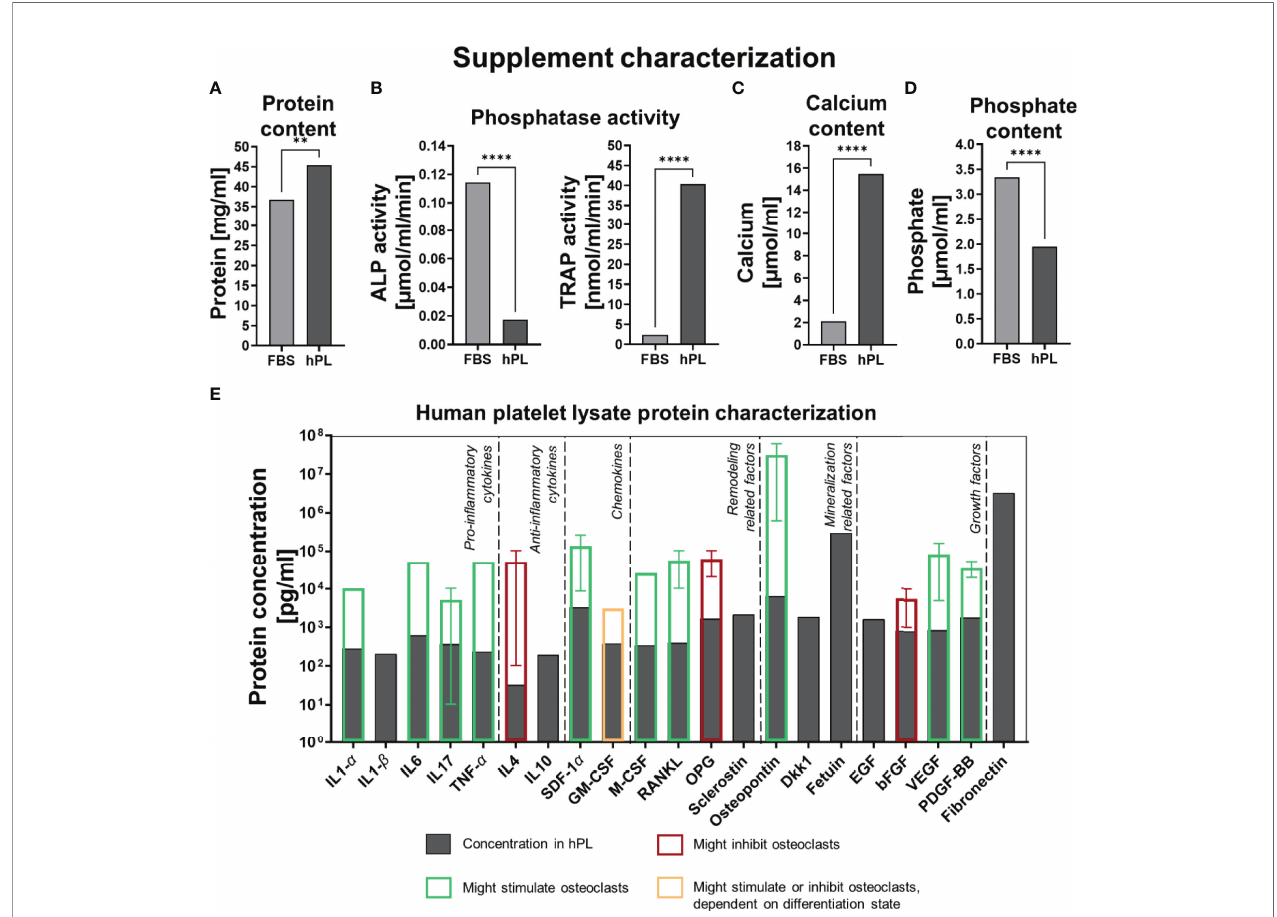
FIGURE 5 | (A) Protein concentration in FBS and hPL, p <0.05 (independent t-test). (B) Phosphatase activity (ALP and TRAP) in FBS and hPL, p < 0.05 (independent t-test). (C) Calcium concentration in FBS and hPL, p < 0.05 (independent t-test). (D) Phosphate concentration in FBS and hPL, p < 0.05 (independent t-test). Asterisks indicate signi fi cant differences (** p < 0.01, **** p < 0.0001). (E) Quanti fi cation of bone and bone-remodeling related factors in hPL. Transparent bars indicate the mean effective concentration found by in vitro experiments from literature, error bars represent minimal and maximal reported effective concentration, border color represents the direction of the found effect. fetal bovine serum (FBS), human platelet lysate (hPL), alkaline phosphate (ALP), tartrate resistant acid phosphatase (TRAP), interleukin (IL), tumor necrosis factor (TNF), stromal derived factor (SDF), granulocyte-macrophage colony-stimulating factor (GM-CSF), macrophage colony-stimulating factor (M-CSF), receptor activator of nuclear factor k B ligand (RANKL), osteoprotegerin (OPG), Dickkopf WNT Signaling Pathway Inhibitor 1 (Dkk-1), epidermal growth factor (EGF), basic fi broblastic growth factor (bFGF), vascular endothelial growth factor (VEGF), platelet derived growth factor- BB